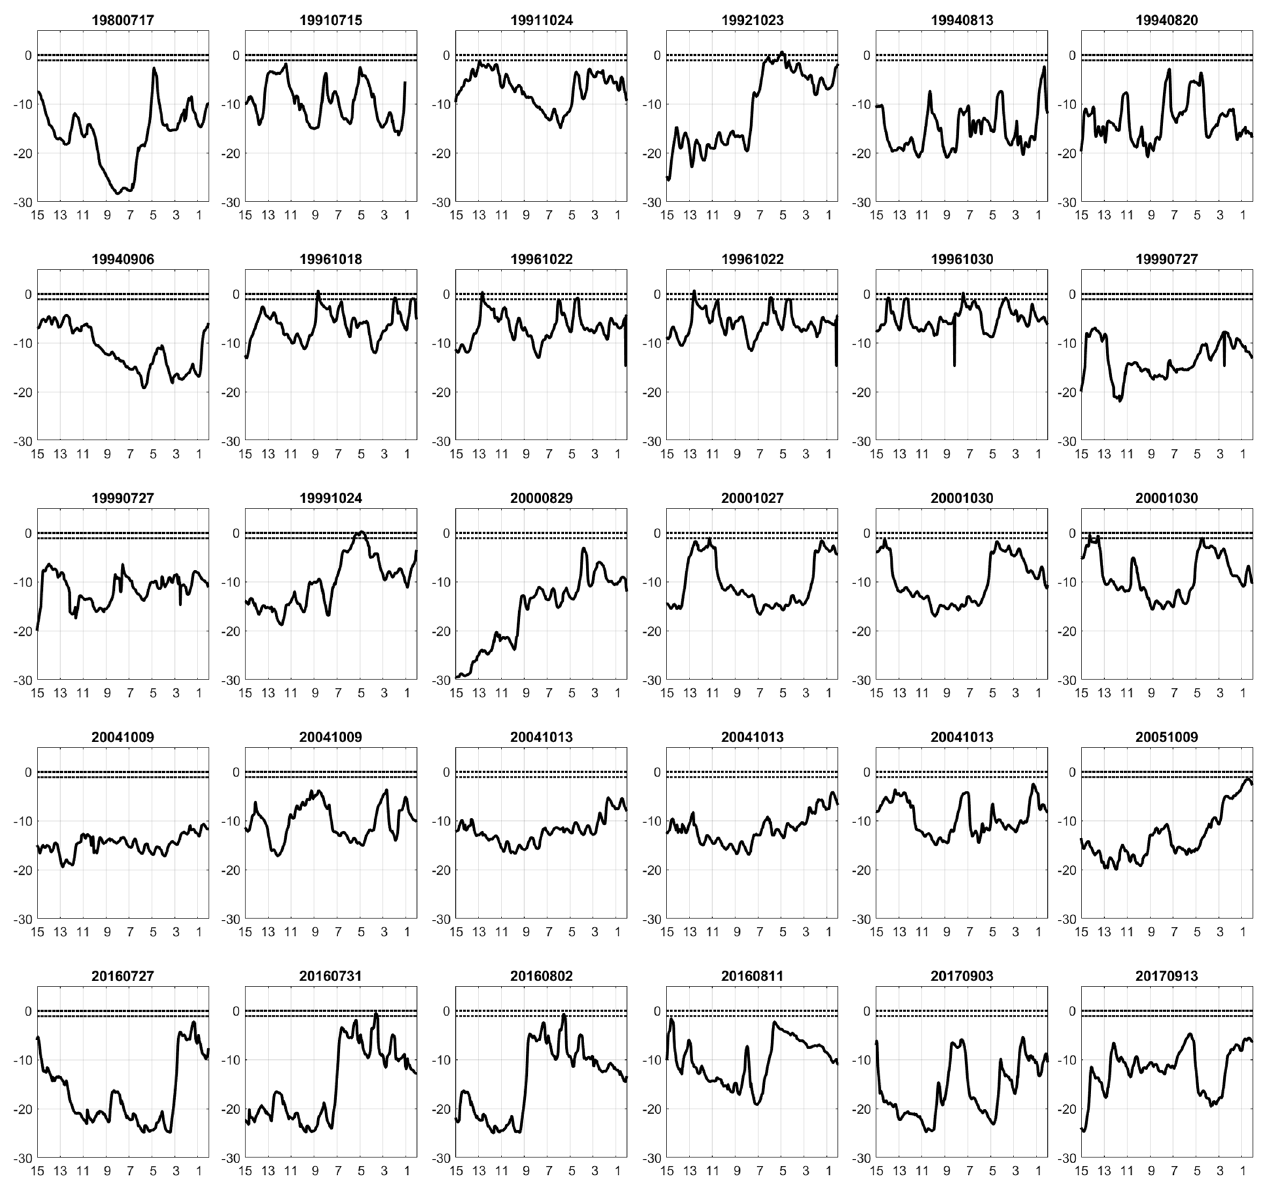
Figure B2. Time series of the 2m air temperature at the location of the polynya, over the 15d leading to the polynya event (date of the event in the panel title). The x axis indicates days before the polynya event; the y axis indicates air temperature in ◦ C. Horizontal dashed lines indicate the freezing temperature for young salty ( − 1.1 ◦ C) or older fresh (0 ◦ C) sea